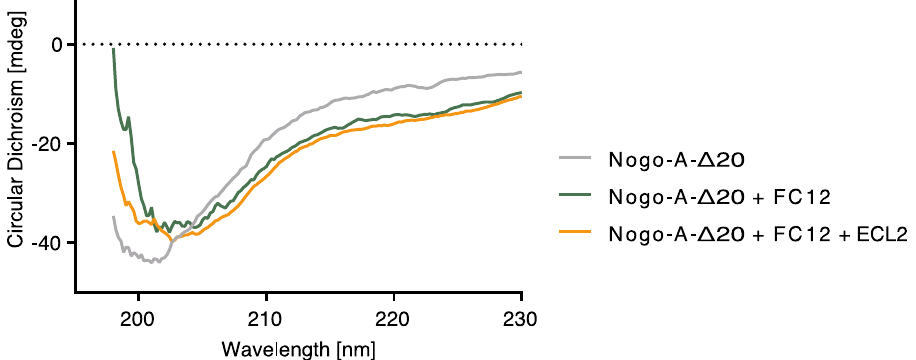
Fig 1. CD spectroscopy of Nogo-A- Δ 20 at 25°C. Recombinant Nogo-A- Δ 20 exhibits a spectrumtypical for unstructured proteins.Additionof FC12,thoughtto mimica membrane environment, slightlyenhancesthe structural compositionof the protein.However, the observed changes are negligible comparedto the α - helicalstructurereportedfor Nogo-66upon FC12 addition[19].Additionof ECL2 to Nogo-A- Δ 20 in a membrane-mimickingenvironmentdoes not lead to folding,